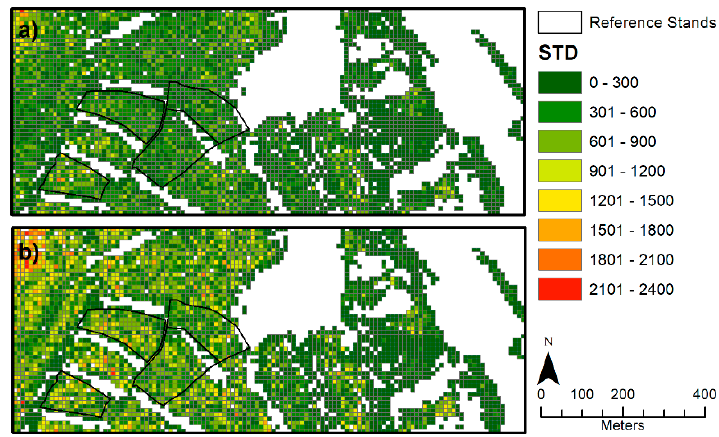
Figure 6. Maps of stand density index over grid cell (10 × 10 m): ( a ) Multisource-based method and ( b ) raster-based method.